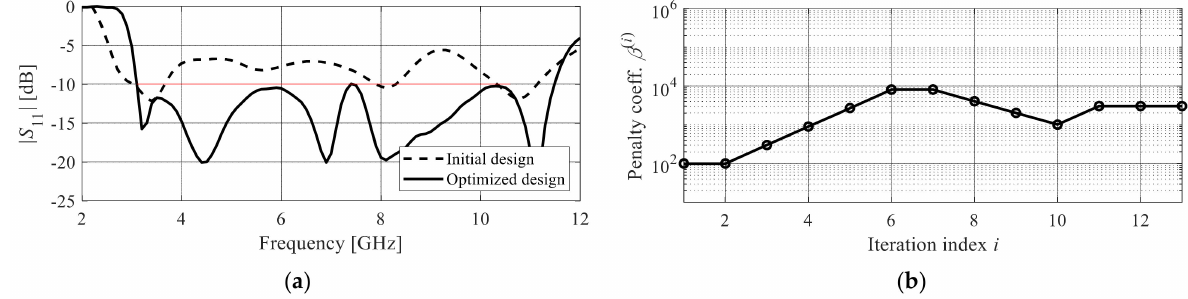
Figure 4. Representative run of the algorithm [42] optimizing the antenna of Figure 3: ( a ) antenna reflection characteristics at the initial (- - -) and optimized design (—), horizontal line marks design specifications; ( b ) evolution of penalty factor value across optimization